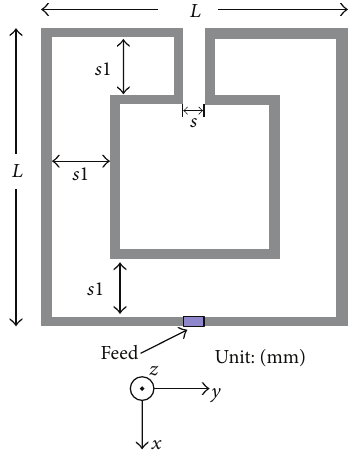
Figure 2: Prototype of the folded-dipole loop antenna.